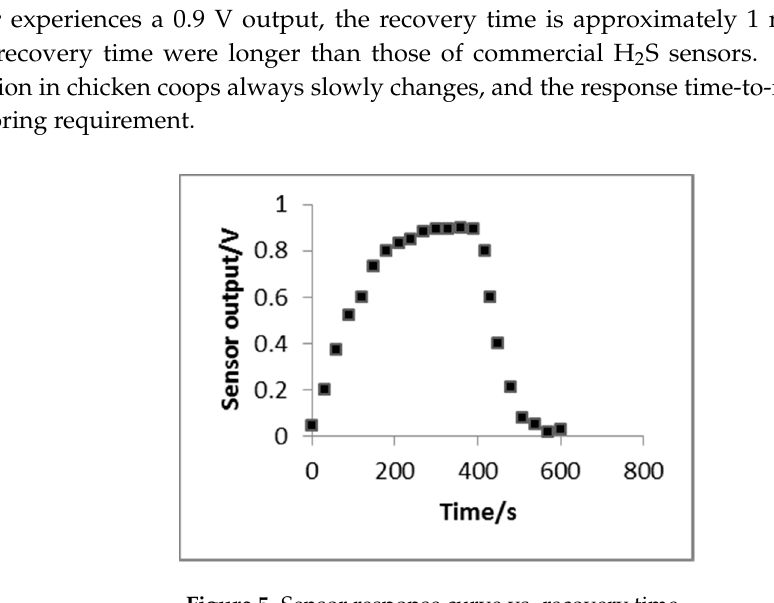
Figure 5. Sensor response curve vs. recovery time.